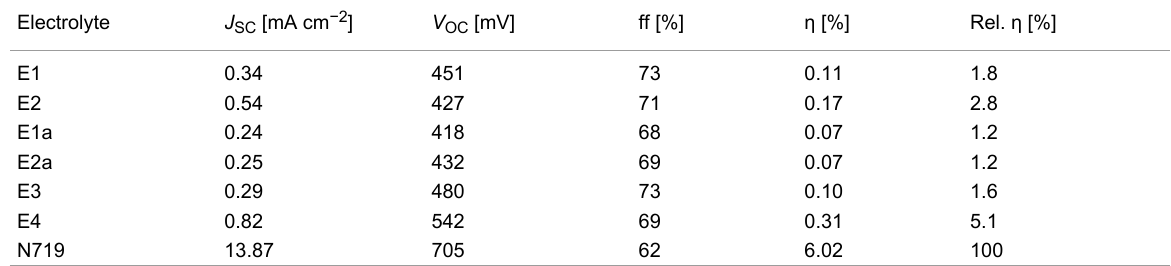
Table 2: Parameters for masked DSCs using electrolytes with different ionic liquids with MPN and MeCN as solvent. Measurements a were made on the day of sealing the cells. See Supporting Information File 1, Table S1 for data for multiple DCSs. Data are referenced with respect to a DSC with N719.